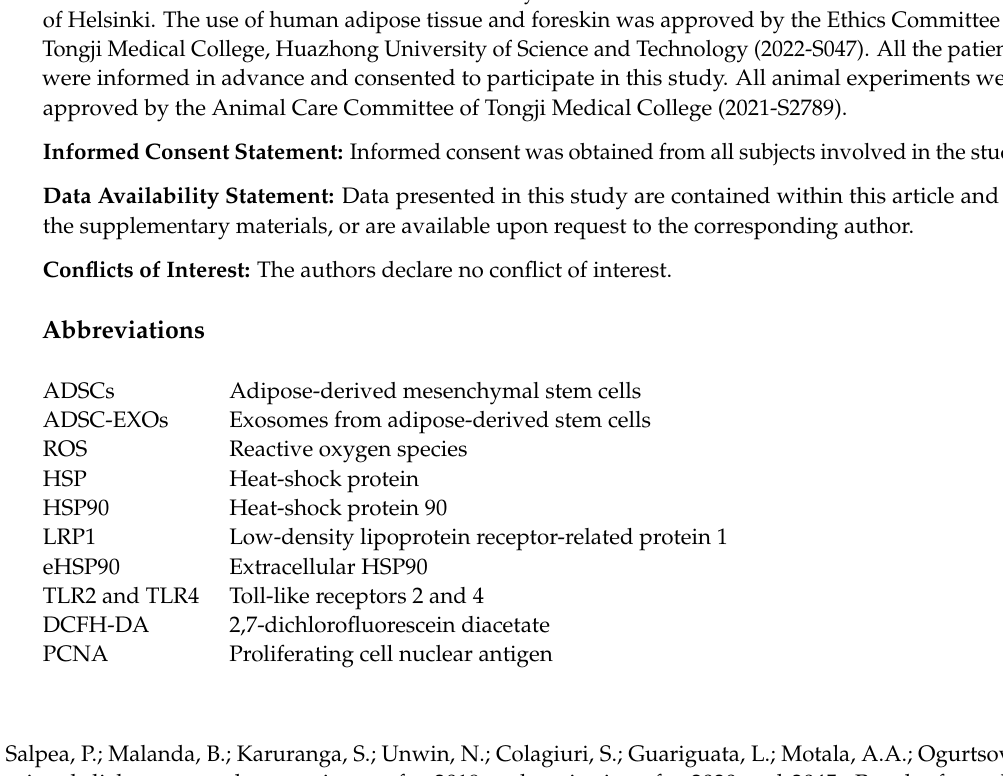
Identification of ADSCs-EXOs. Figure S3: ADSC-EXOs promoted skin cell proliferation. Figure S4: ADSC-EXOs promoted skin cell migration. Figure S5: ADSC-EXOs promoted endothelial cell angiogenesis. Figure S6: ADSC-EXOs protect skin cells against damage from hypoxia and oxidative stress. Figure S7: ADSC-EXOs activated the AKT and ERK signaling pathways in skin cells. Figure S8: U0126 (an ERK inhibitor) could not affect the function of ADSC-EXOs. Figure S9: ADSC-EXOs promoted cell proliferation in diabetic wounds; Table S1: The sequences of three different sh-LRP1. Table S2: Protein Report. Table S3: GO analysis of